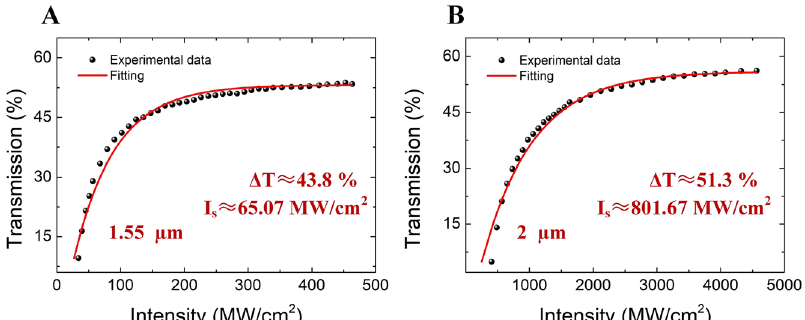
Figure 3: The nonlinear absorption transmission curves of GMPDs in (A) 1.55 µm and (B) 2 µm